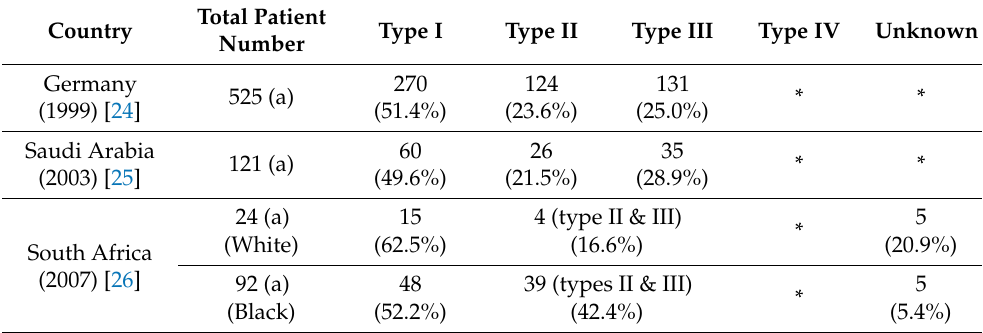
Table 4. Subtype distribution in